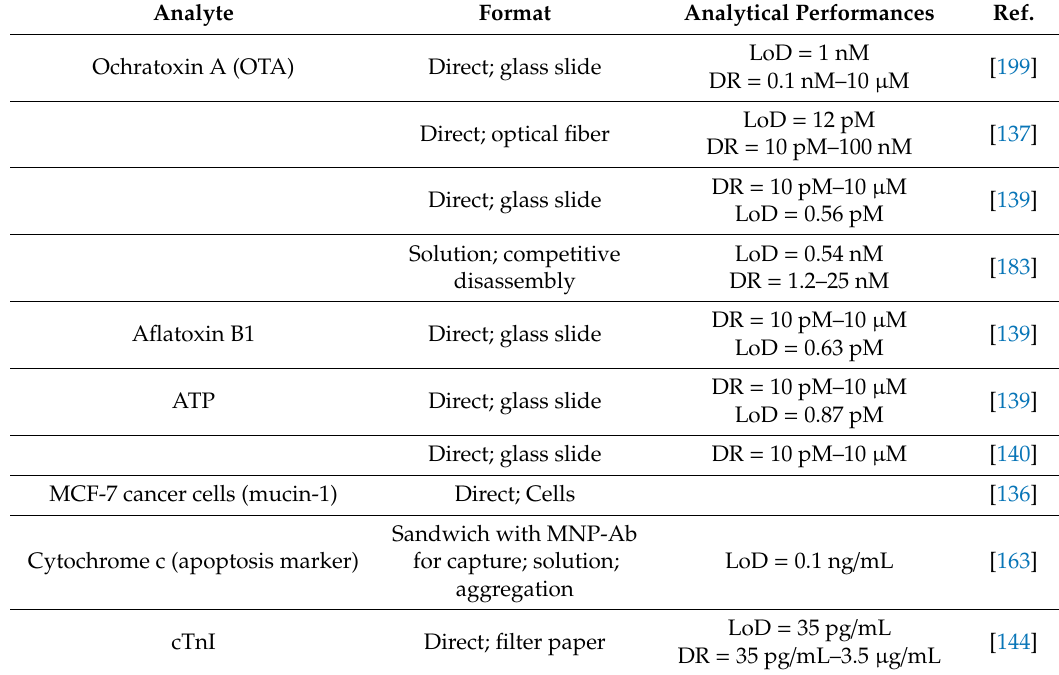
Table 6. Strategies, analytes, and analytical performances for